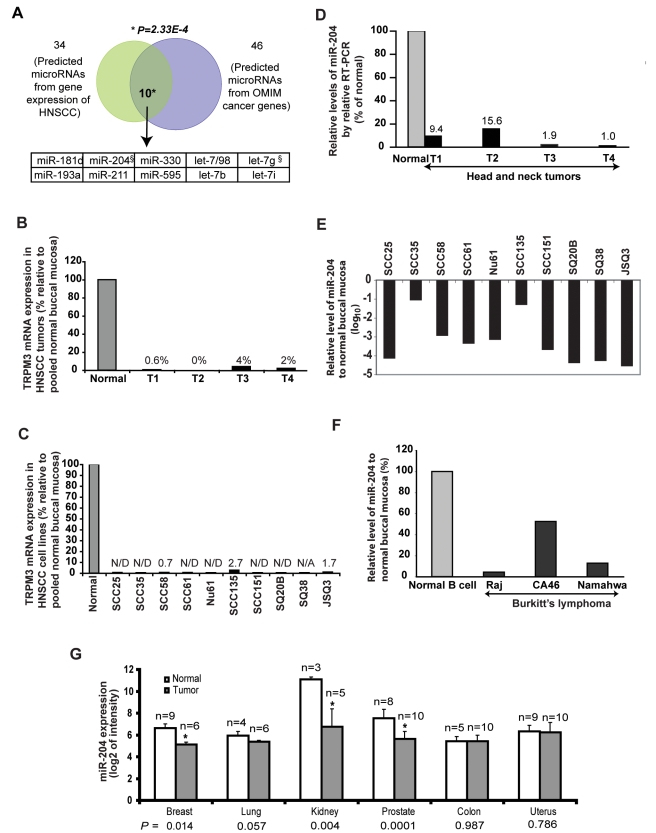
Combining genome-scale predictive strategies to predict and prioritize candidate microRNAs in HNSCC.(A) Enriched gene targets of 46 microRNAs among inheritable cancer genes in OMIM are significantly overlapping with 34 predictions of deregulated microRNAs based on HNSCC expression arrays (GSE6631, GSE2379; Figure S3; Table S2 and Table S3), yielding ten prioritized microRNAs (P = 2.33×10−4). P: Cumulative hypergeometric Statistics. §: miR-204 and let-7g are located in chromosomal regions with known increased genetic risk of HNSCC (9q21.1–22.1 for miR-204 and 3p21 for let-7g, respectively) [15]. (B–C) mRNA expression of TRPM3, the host gene of miR-204, is significantly downregulated and is barely detectable in four microdissected head and neck tumors (B) and in a panel of ten low passage HNSCC cell lines [26] (C). TRPM3 mRNA expression was determined by qRT-PCR and normalized with the TBP endogenous gene control. Triplicate real time PCR measurements were obtained and the mean Ct (cycle threshold) was used to calculate RQ values. Standard deviation of the triplicate measurement was less than 0.15 Ct. Shown are relative tumor TRPM3 mRNA expression levels compared with five pooled normal buccal mucosa. (D–F) Quantification of miR-204 expression by Taqman qPCR in four laser micro-captured head and neck tumors (D), in ten HNSCC cell lines (E) and in three Burkitt's B-cell lymphoma cell lines (F). Five equally pooled normal buccal mucosa RNAs were used as the normal control for HNSCC tumors and cell lines. Normal B cell RNA was used as the normal control for Burkitt's B-cell lymphoma. (G) Comparison of miR-204 expression between six types of human epithelial cancers tissues and their respective normal tissues was conducted using the microRNA profiling dataset GSE2564 [18] (P-values were calculated using two-tail unpaired t-test; “n” indicates number of patients; error bars represent mean ± standard error of the mean, Materials and Methods).